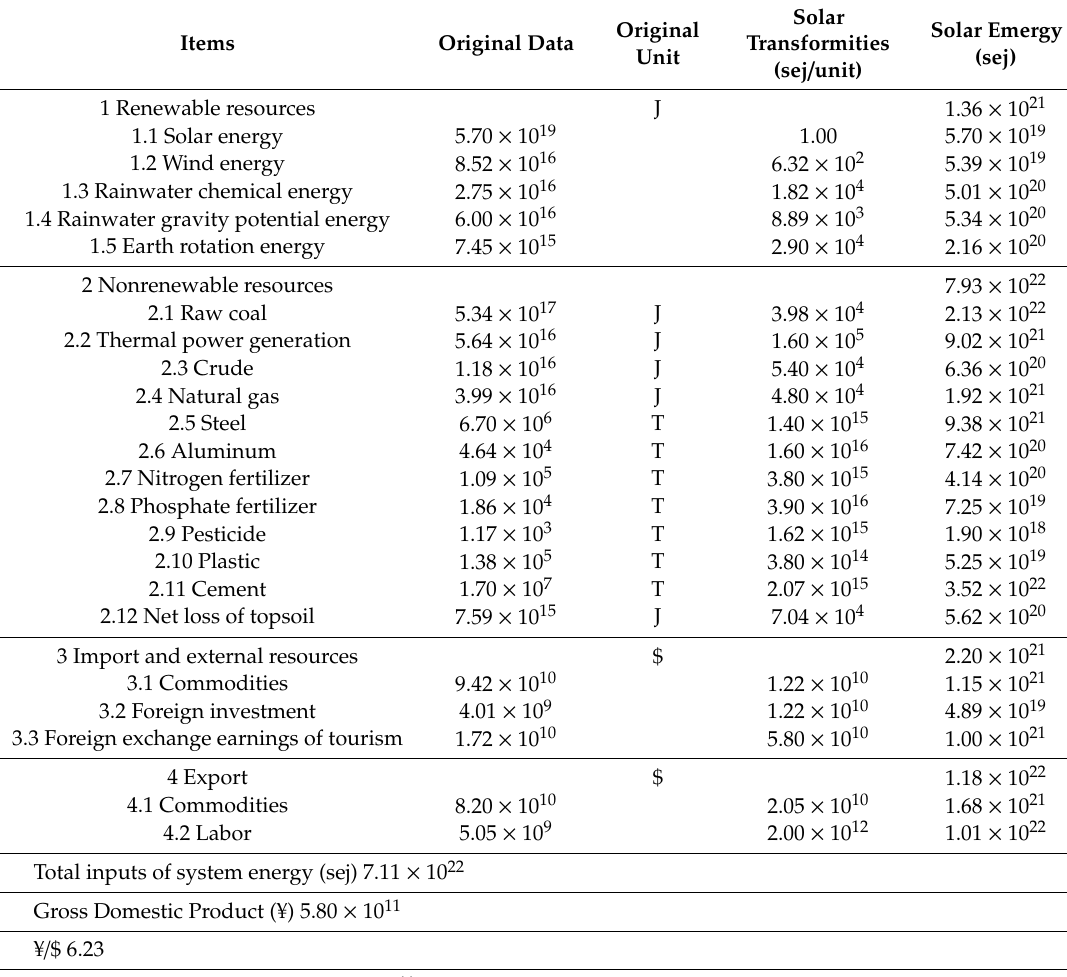
Table 3. Emergy / currency ratio of Xi’an City in